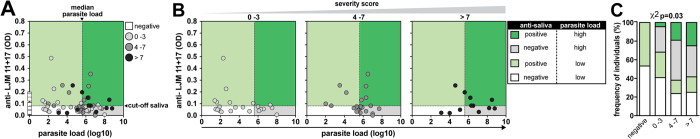
Associations between antibodies production against salivary recombinant proteins LJM11 and LJM17 and parasite load of infected dogs.(A) Correlations between parasite load and antibodies production against salivary recombinant proteins LJM11 and LJM17 in negative and infected dogs showing different clinical signs (n = 70). Dotted lines on the X-axis represent the median value of parasite load within the group of infected dogs, while dotted lines on Y-axis indicate the cut-off value for antibodies production against LJM11 and LJM17. In (B), the correlations were stratified according to clinical score presented by the dogs. White areas designate the quadrants that include the dogs displaying values of parasite load below the median and negative antibodies production; light green area designate the quadrants that include the dogs displaying values of parasite load below the median and positive antibodies production; dark green areas designate the quadrants that include the dogs displaying values of parasite load above the median and positive antibodies production; and grey areas designate the quadrants that include the dogs displaying values of parasite load above the median and negative antibodies production. In (C) the percentage of individuals within each area were compared between the groups with different clinical score using a chi-square analysis.